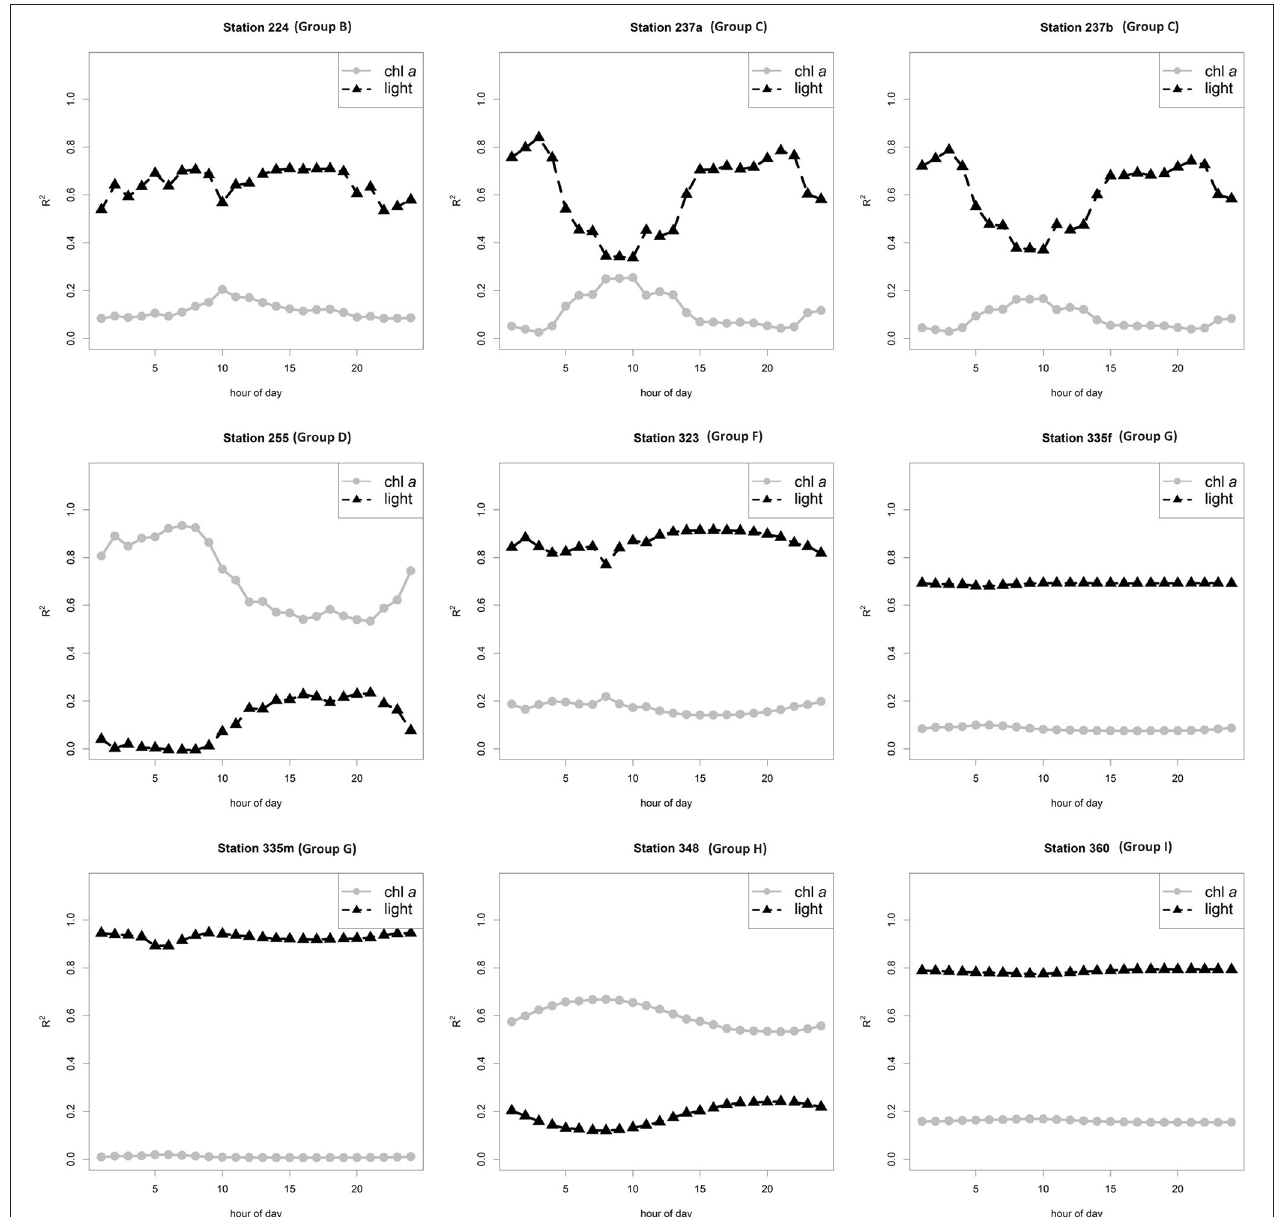
( Table 1 ). When comparing chl a biomass values at coincident identified sea ice ridges with chl a biomass at level ice for each SUIT haul separately, we observed significantly higher (Wilcoxon test, p < 0.05) sea ice ridge chl a biomass than level ice chl a biomass at 2 SUIT hauls (stations 223 and 233; Table 5 ). When comparing all SUIT observations combined, sea ice ridge chl a biomass (median: 0.7 and IQR: 0.2–1.4 mg chl a m − 2 ) was significantly higher (Wilcoxon test, p < 0.05) chl a m − 2